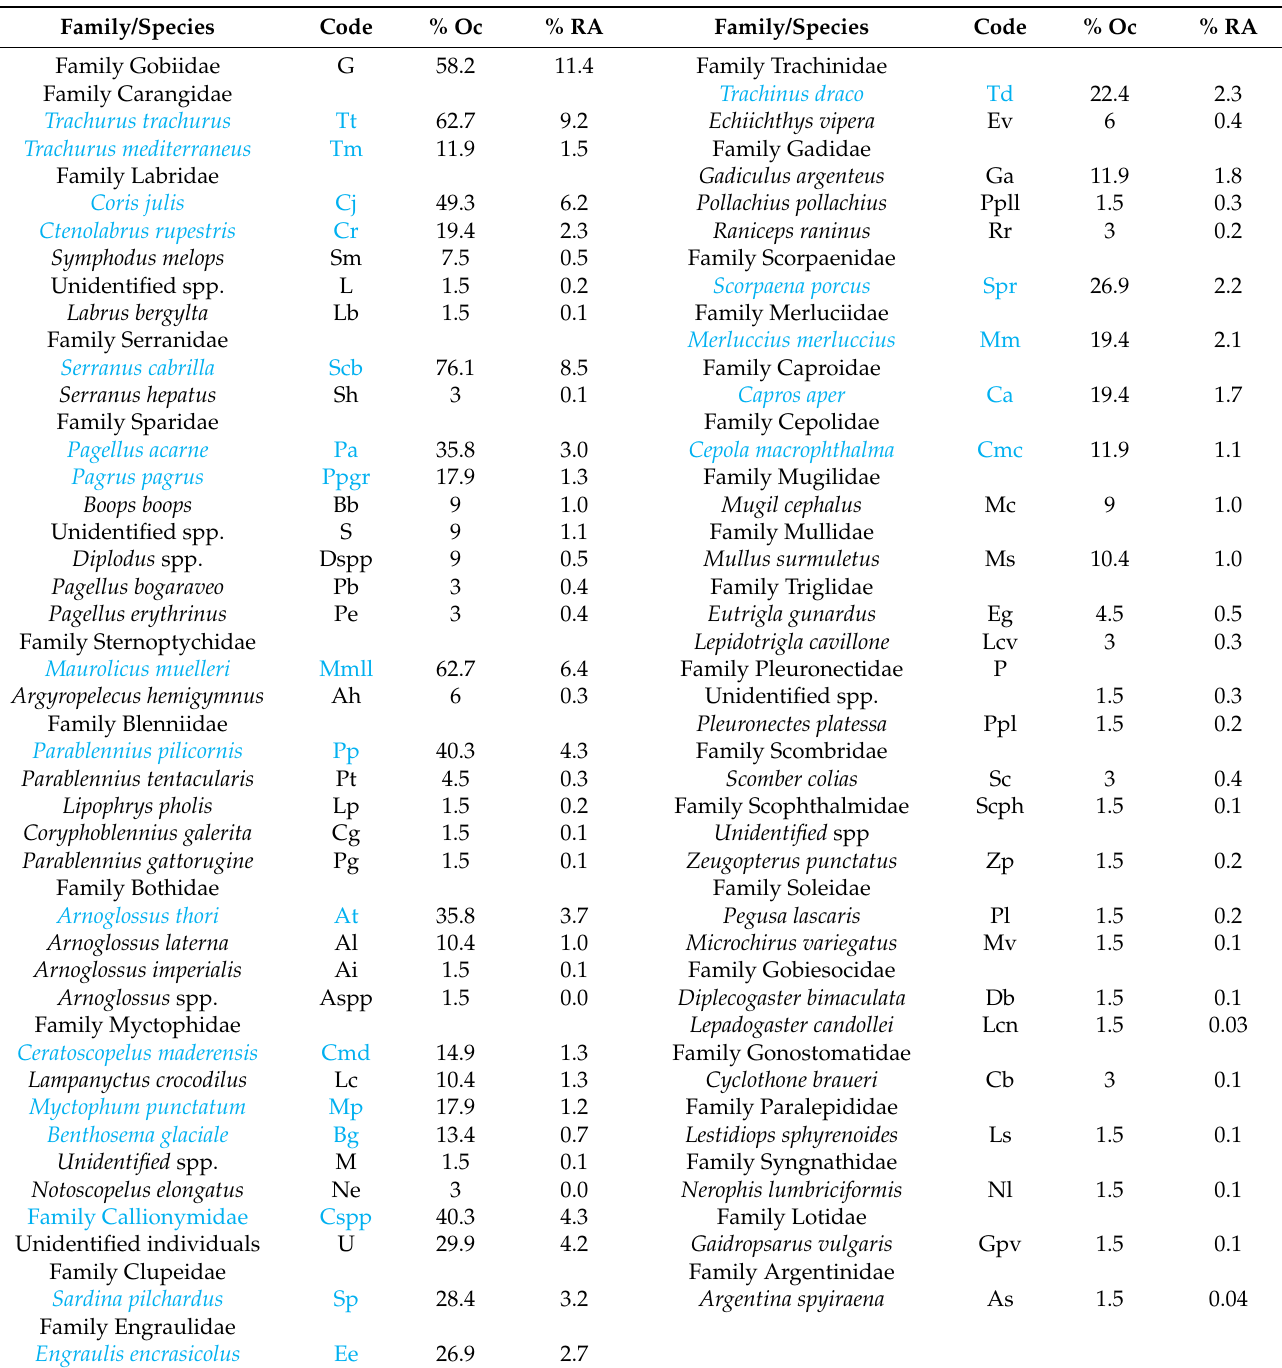
Table 1. List of larval fish species grouped by families collected off the Galician coast during the Cramer1207 research survey. The families are ordered by decreasing abundance. Code: taxon code; Oc: percentage of occurrence (%); RA: relative abundance (%). The taxa written in blue are those with relative abundances >0.2 larvae 10 · m − 2 and that were present in >5% of the stations, therefore were included in subsequent